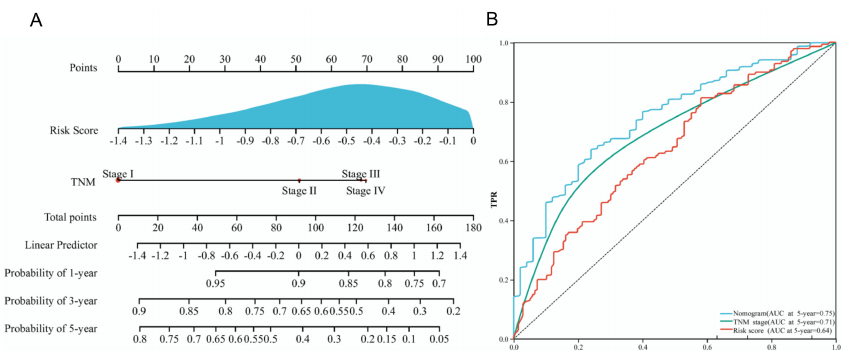
Figure 4. Nomogram integrating risk score and clinical features. ( A ) Nomogram for predicting 1-, 3-, and 5-year overall survival rates of patients with LUAD. ( B ) ROC curves of the risk score, TNM stage, and nomogram. AUC, areas under the ROC curve. FPR, false positive rate. TPR, true positive rate.